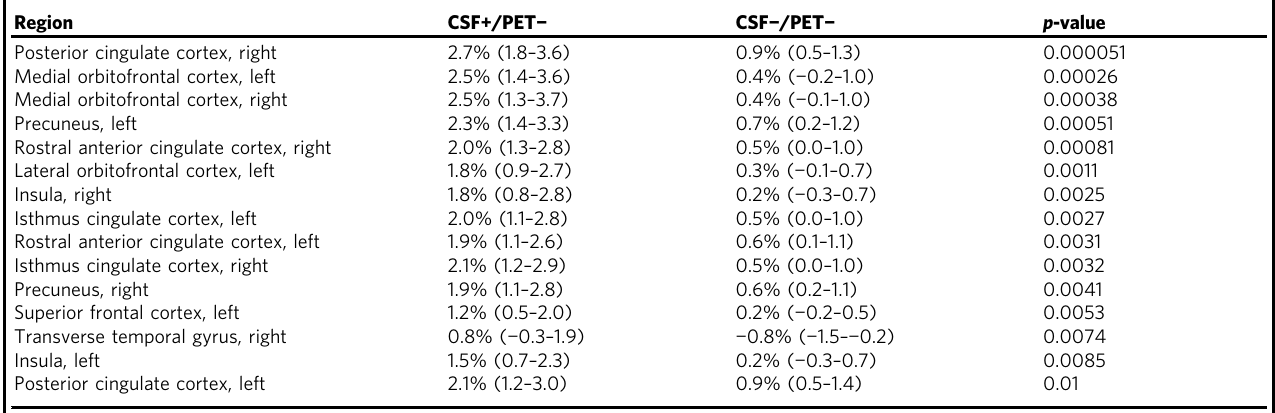
Table 2 Annual A β accumulation rates in the signi fi cant early A β regions in ADNI Region CSF+/PET − CSF − /PET − p -value Posterior cingulate cortex,